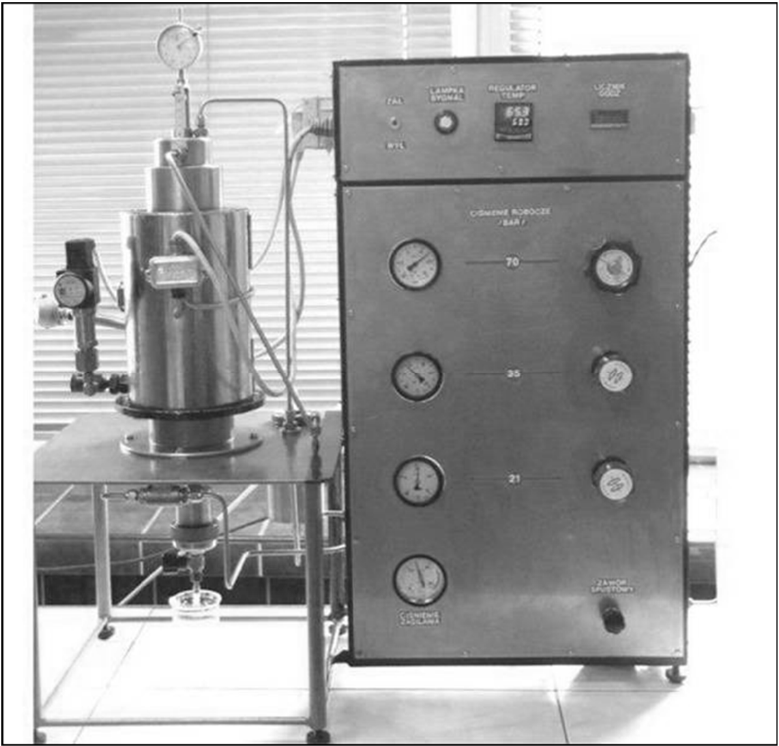
Figure 4. Apparatus for testing gas migration during slurry bonding—hydraulic press (OGI-NRI design).